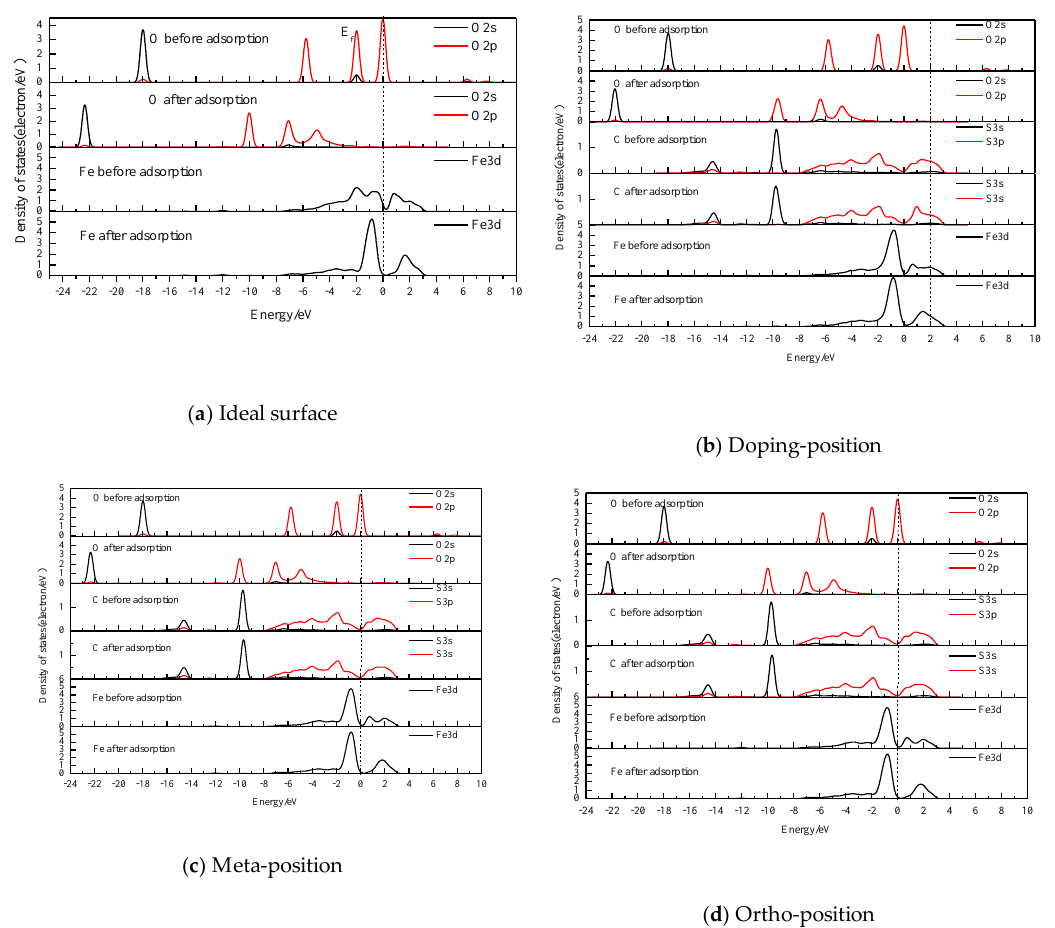
Figure 6. Density of states (DOS) of atoms before and after H 2 O adsorption at different sites of pyrite surfaces. pyrite